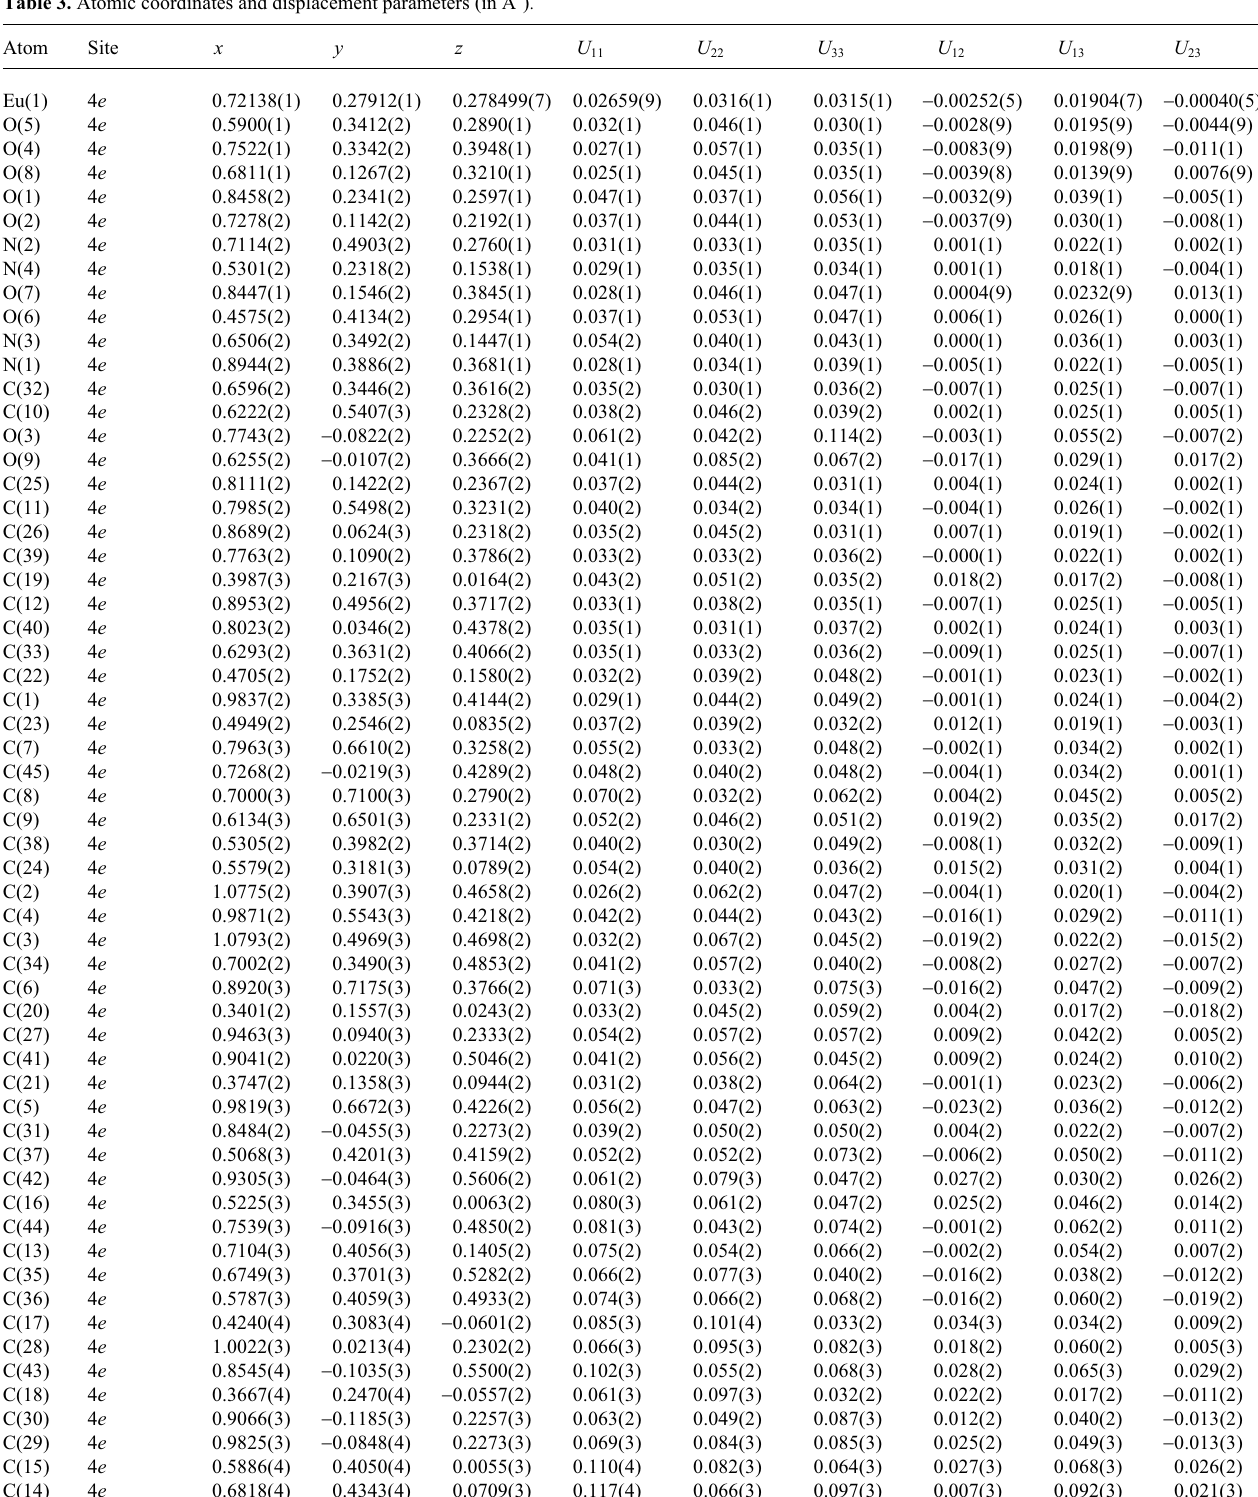
Table 3. Atomic coordinates and displacement parameters (in Å 2 )